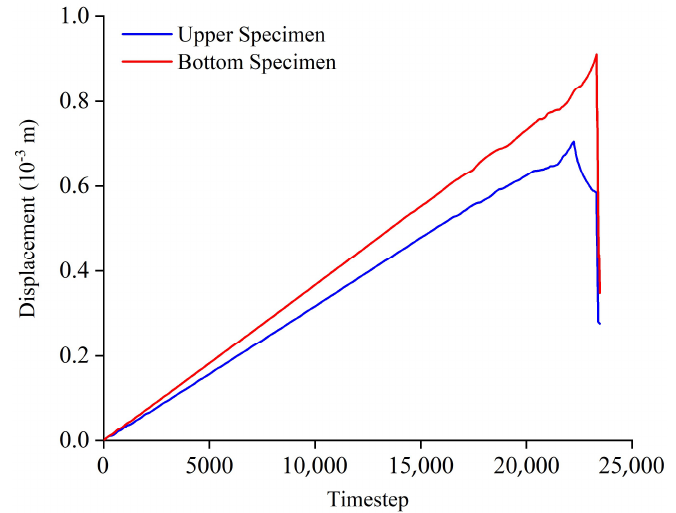
Figure 15. Local displacement evolution of upper and bo(cid:308)om specimens.